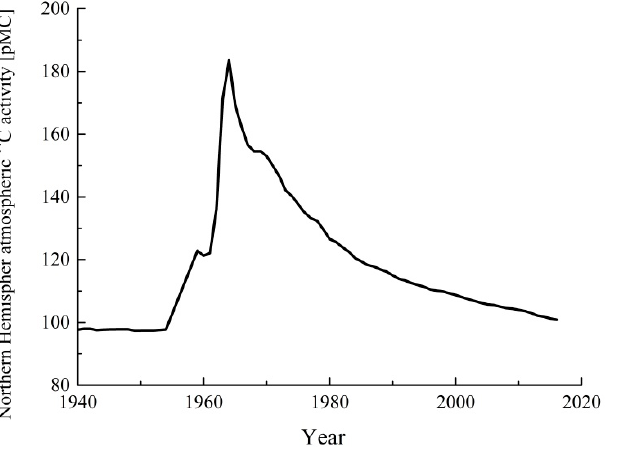
Figure 1. The 14 C activity of the Northern Hemisphere atmospheric background, from 1940–2016